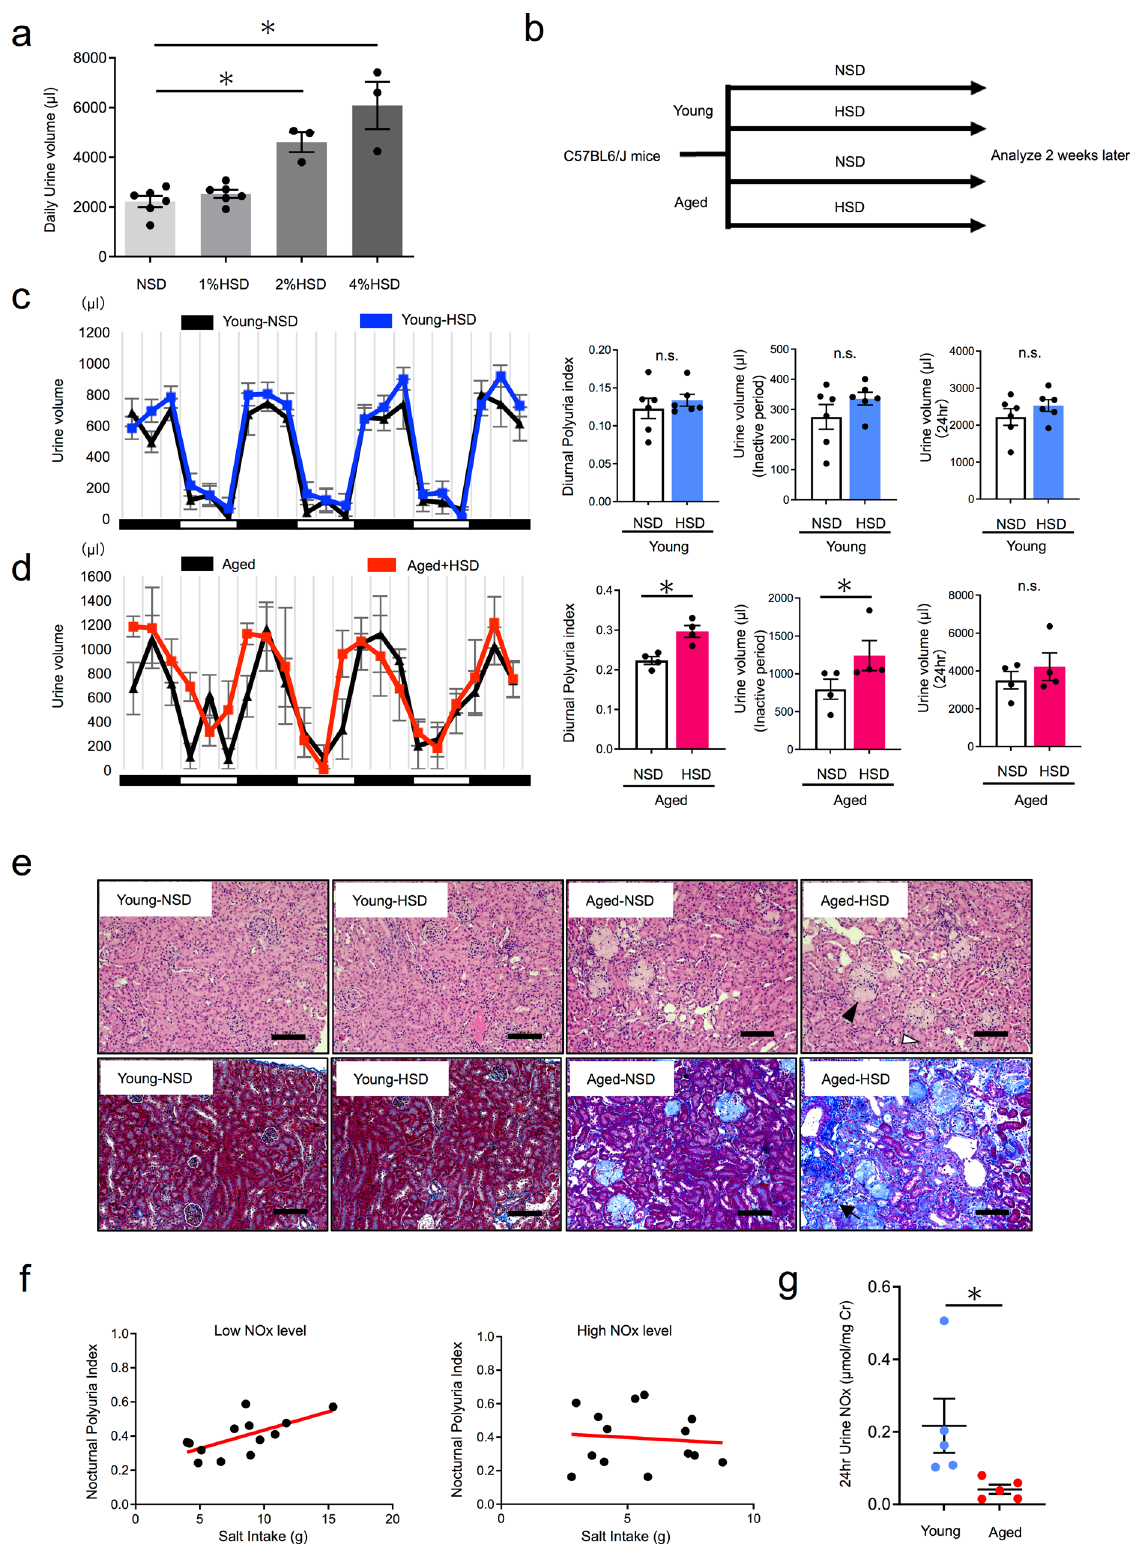
subjects 25 . Histopathological analysis of the kidney revealed no glomerulosclerosis, tubular atrophy, or fi brosis of the interstitium in all four groups (Fig. 2e). Systolic blood pressure was sig- ni fi cantly elevated after L -NAME compared to tap water (Table 1). To investigate whether elevated blood pressure causes nocturnal polyuria seen under L -NAME + HSD, we